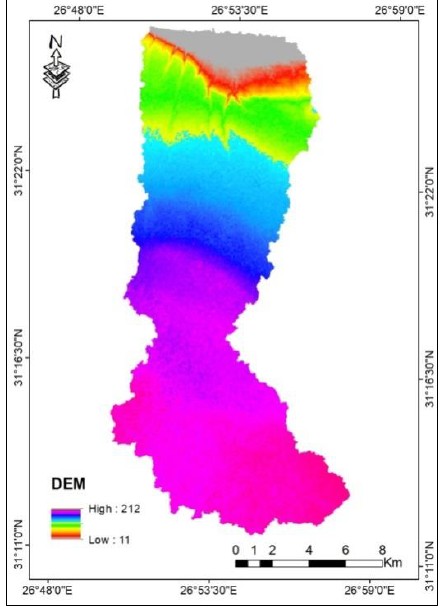
Figure 3. Digital elevation model (DEM) of the investigated area.